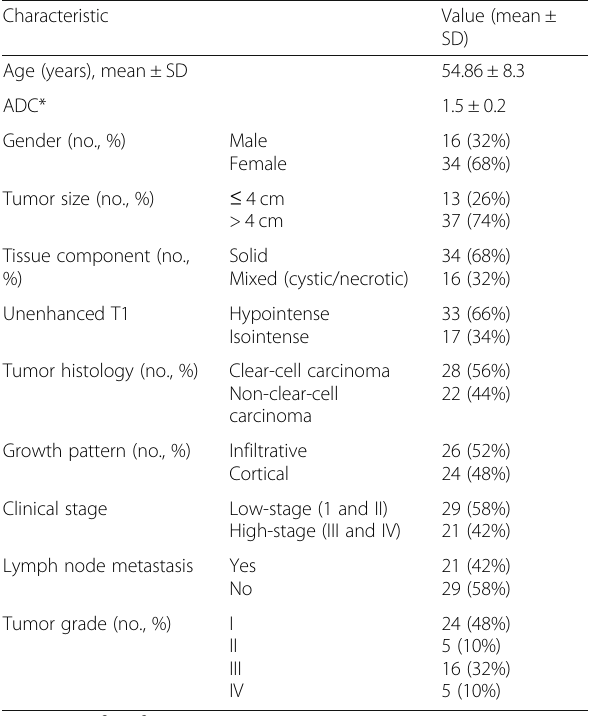
Table 1 Features of prognostic factors of 50